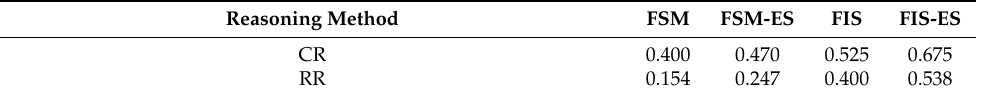
Table 14. Summary of diagnostic accuracy indicators for the tested methods Reasoning